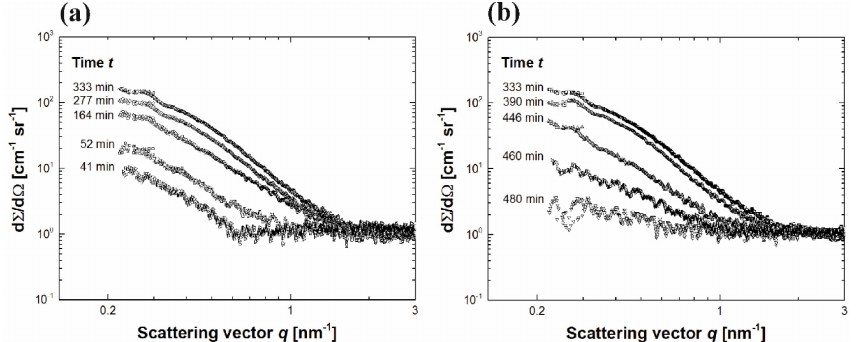
Figure 11. Selected averaged scattering curves during isothermal annealing and subsequent heating. Until 333 min (936 ˝ C), p -type carbides precipitate in the γ laths of the α 2 / γ colonies ( a ). Afterwards, their volume fraction decreases again ( b ). The indicated time specifications refer to the time scale set in the time-temperature profile depicted in Figure 10. (Reprinted from Reference [44], Copyright (2014), with permission from